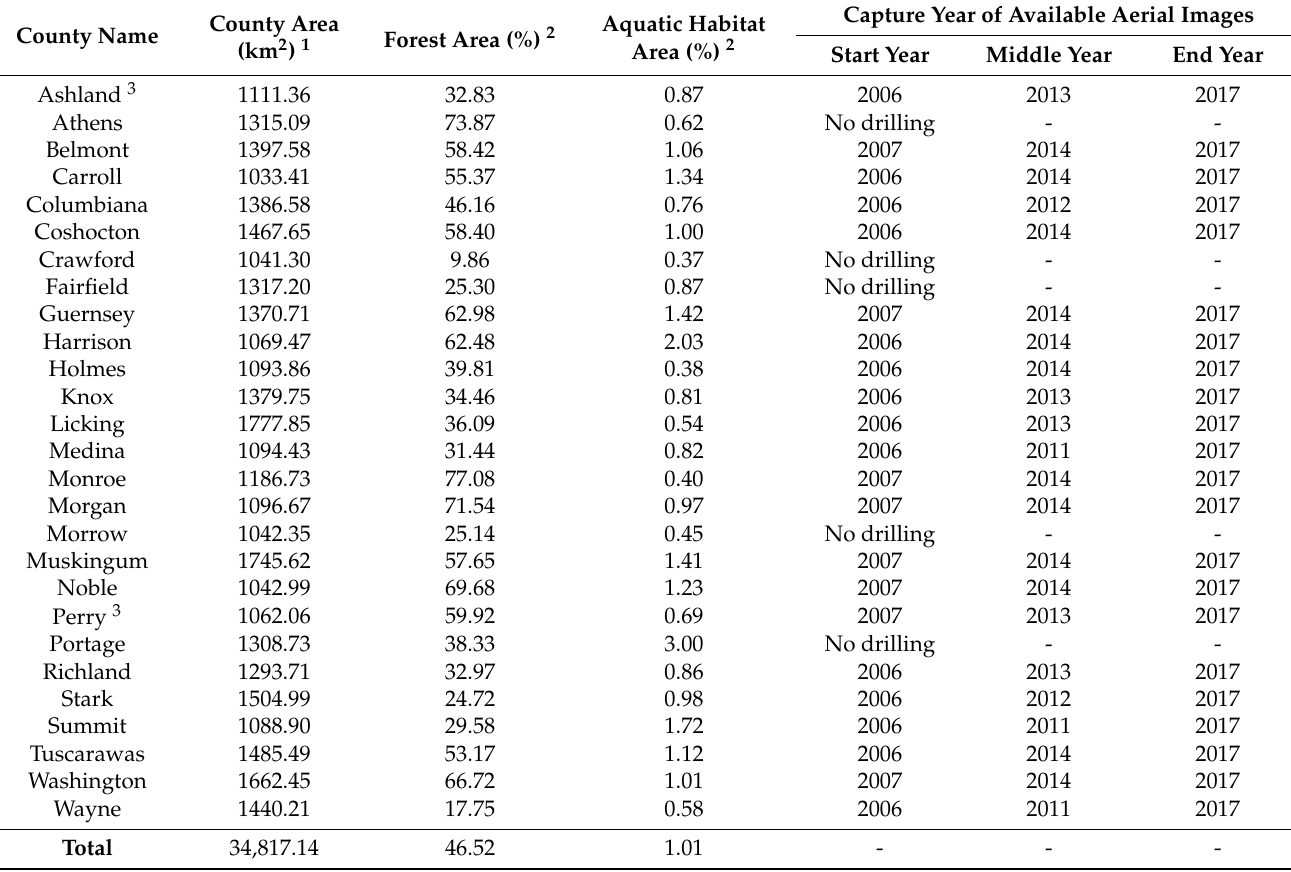
Table 1. Appalachian counties in the Muskingum River Watershed and available aerial